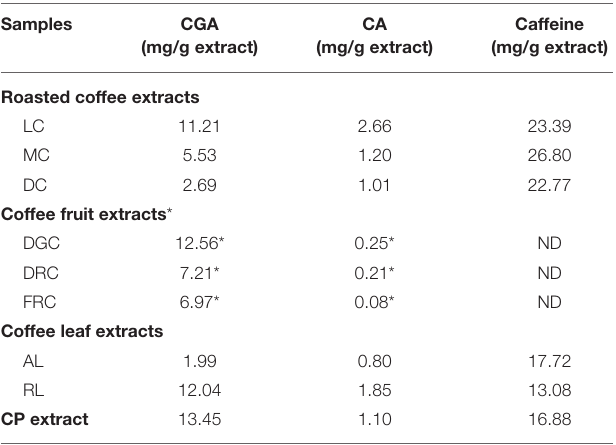
TABLE 1 | The phytochemical profile of the extracts of coffee beans and coffee by-products.